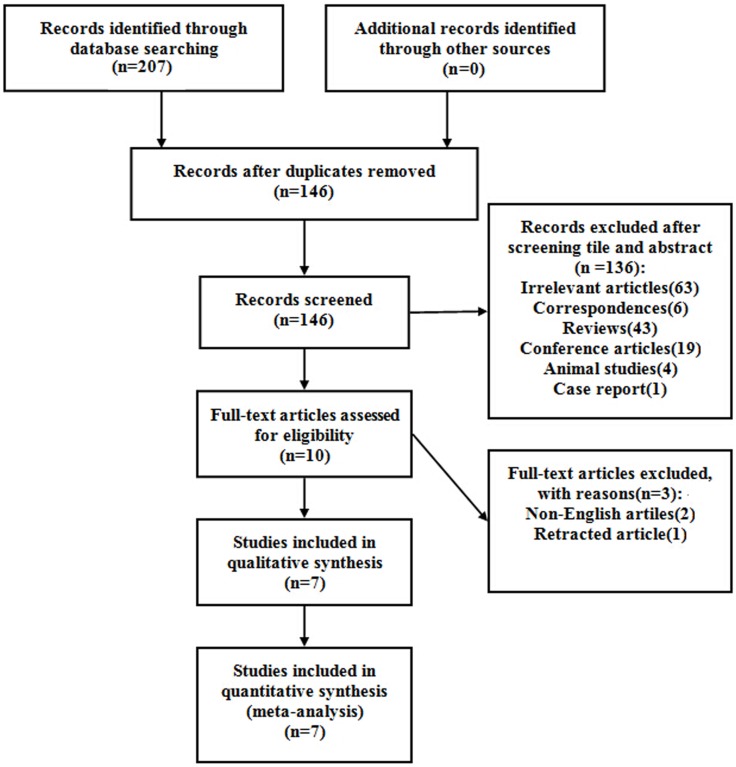
Flow diagram of study selection.